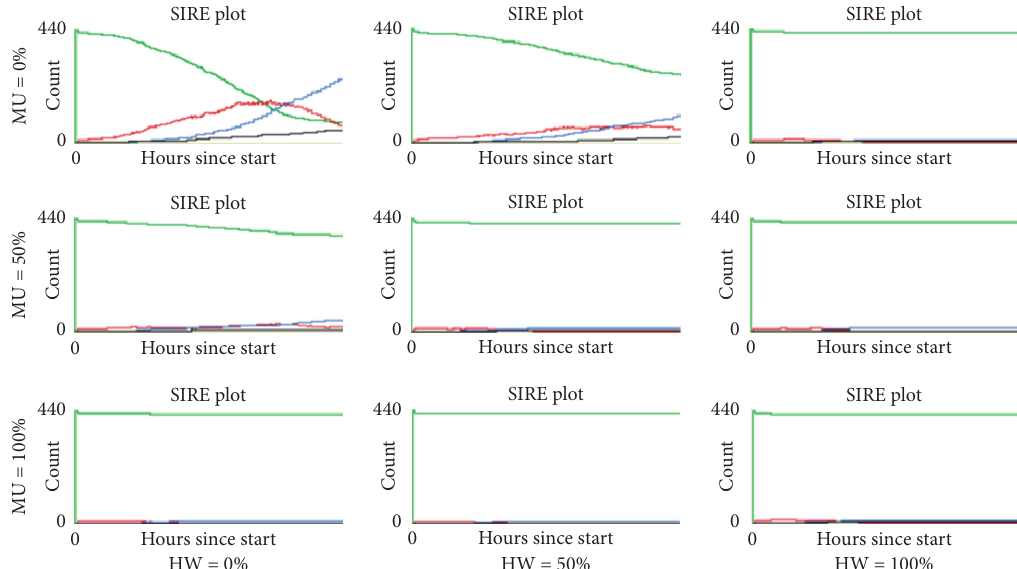
Figure 3: Representative SIRE curves for scenarios with SD � 100% and different combinations of MU and HW proportions (green, susceptible; red, infectious; blue, recovered; black,